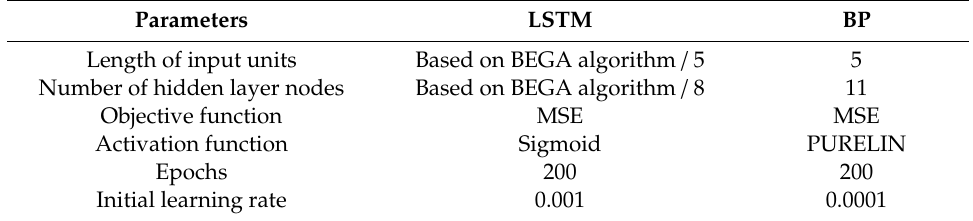
Table 4. Parameter settings of the artificial neural network model.